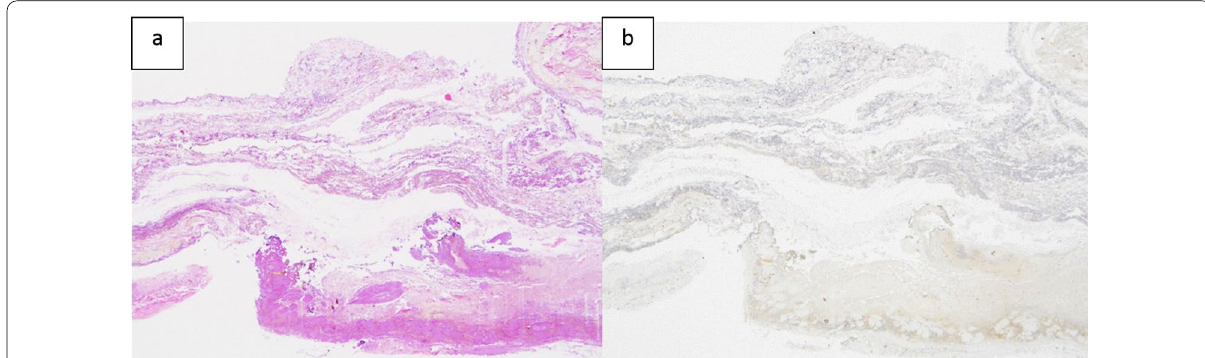
Fig.4 Pathological findings. Hematoxylin and eosin staining revealed that the resected specimen of the common bile duct wall was destroyed that the muscular layer lacked continuity ( a ). Immunohistochemical examination with anti-desmin antibody did not show the presence of smooth muscle in the tissue ( b )